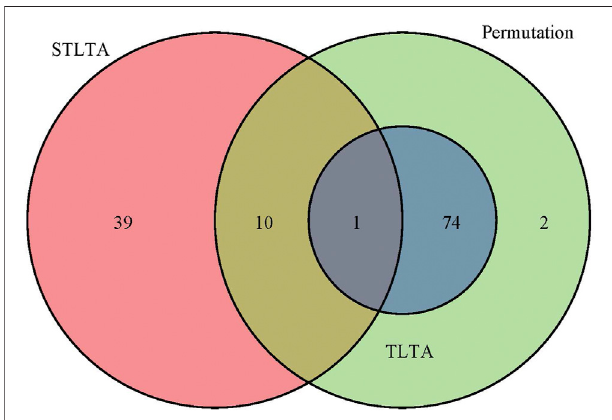
FIGURE 3 | The Venn diagram of the signi fi cant relationships found in permutation test, TLTA and STLTA for the PML data set. Green, blue, and red indicate the number of signi fi cant relationships found by permutation test, TLTA, and STLTA,